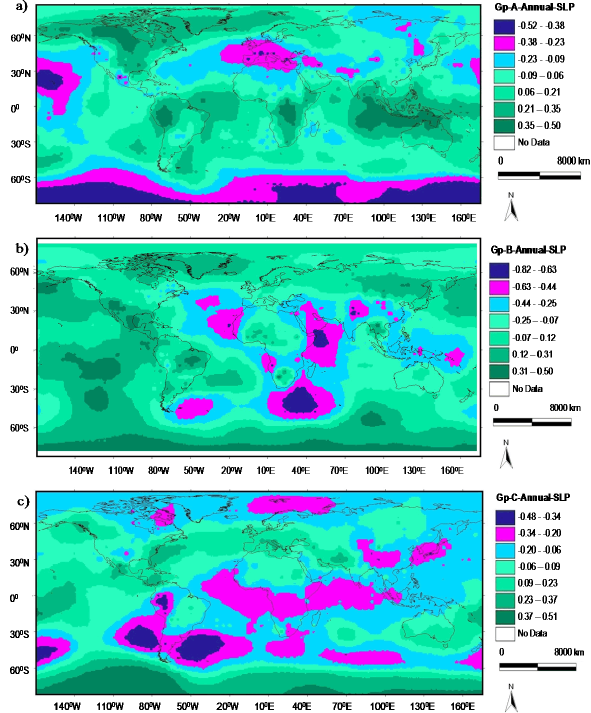
Figure 5. Correlation between anomaly in annual sea level pressure (SLP) and that in region-wide annual rainfall for group (a) A, (b) B, (c) C. In the legend, Gp denotes